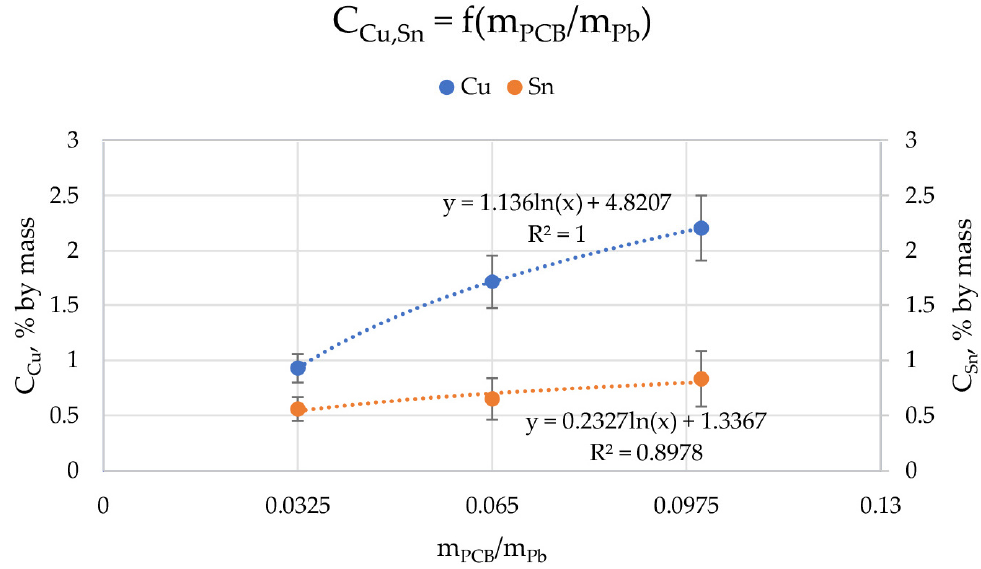
Figure 6. Relationship between the ratio of the weight of scrap to the weight of lead ( m PCB / m Pb ) and copper (C Cu ) and tin (C Sn ) concentrations in ingots after process .